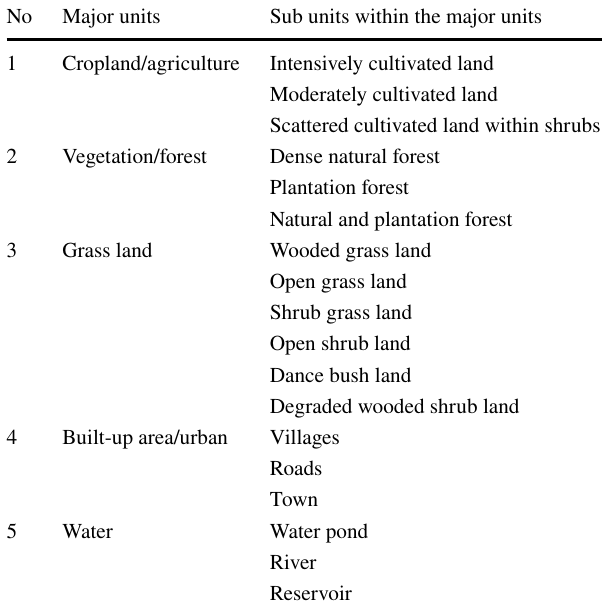
Table 1 Land use/covers classification of study area No Major units Sub units within the major